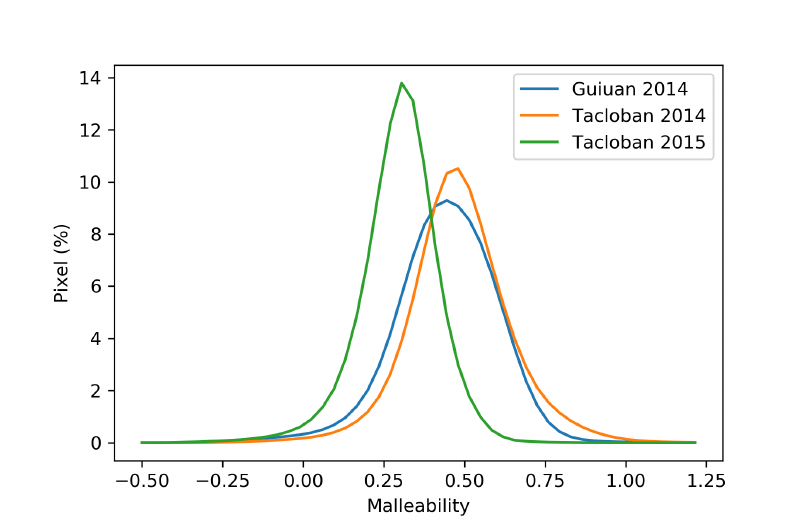
Figure 12. Malleability histogram of the Guiuan and Tacloban